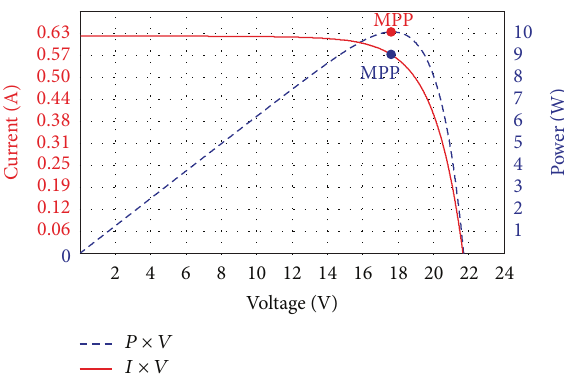
Figure 1: Maximum power point in 𝐼 × 𝑉 and 𝑃 × 𝑉 curves.